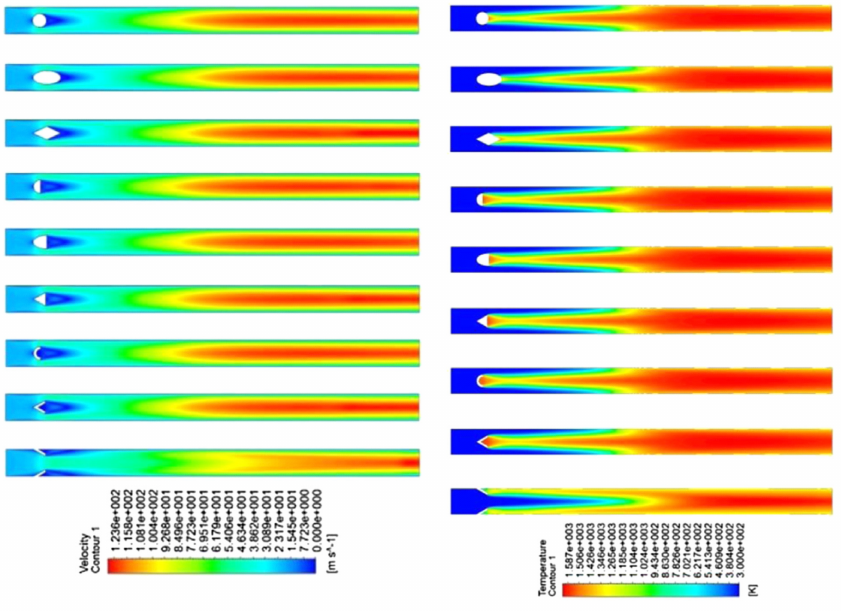
Figure 19. Micro-combustor flame structure and flow